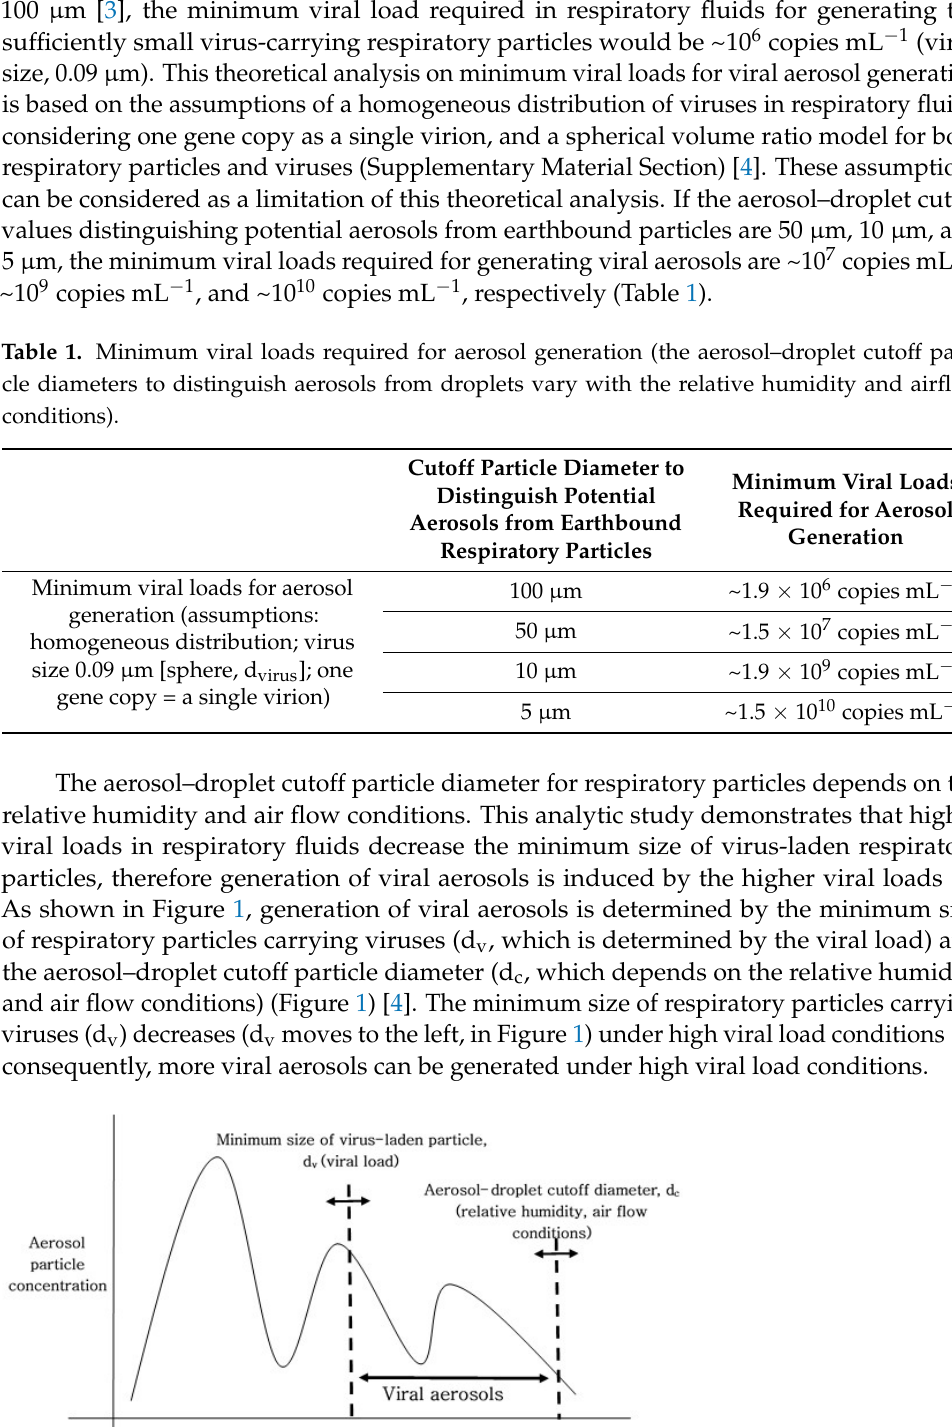
Table 1. Minimum viral loads required for aerosol generation (the aerosol–droplet cutoff parti- cle diameters to distinguish aerosols from droplets vary with the relative humidity and airflow conditions).